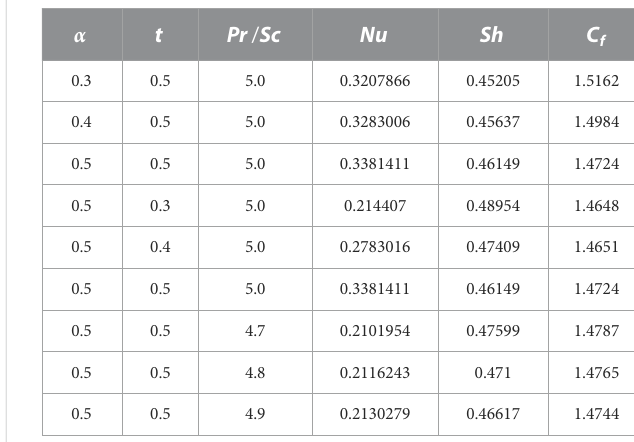
TABLE 3 Numerical results of the Nusselt number, Sherwood number, and skin